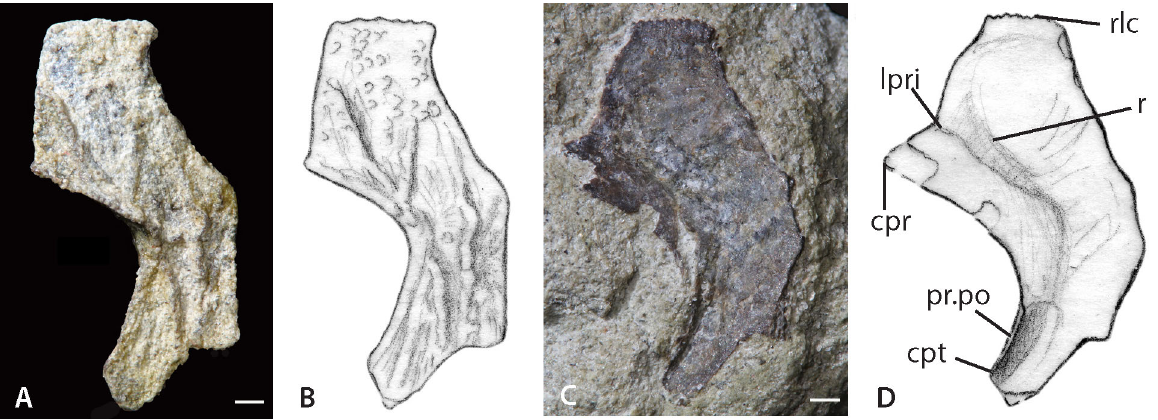
Fig. 3. Microbrachius kedoae from the Gavrilchitsy 45 borehole. A , B , GIT 767-11, a right lateral plate in dorsal view. C , D , GIT 767-2, a left lateral plate in visceral view. Scale bars = 1 mm. Abbreviations: cpr, preorbital angle; cpt, postorbital angle; lpri, lateropremesial ridge of the head-shield; pr.po, antero-lateral corner of otico-occipital depression; r, premedian ridge; rlc, rod-like crenulated anterior